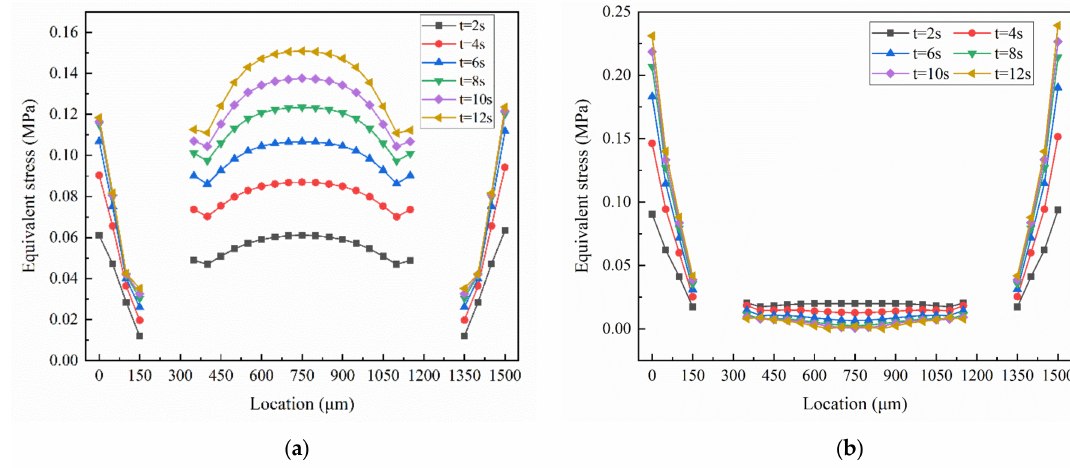
Figure 10. Equivalent stress of the membrane in various time step. ( a ) Lower surface of membrane, ( b ) upper surface of membrane.